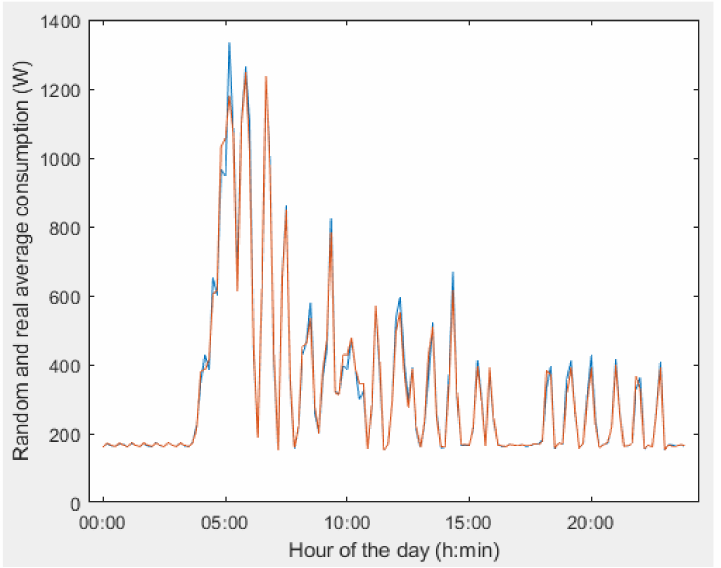
Figure 12. Random (blue) and real (orange) average consumption of HVAC during Sundays.